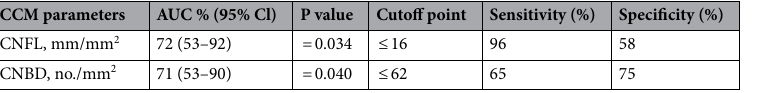
Table 3. Receiver operating characteristic (ROC) curve analysis for the diagnostic accuracy of corneal confocal microscopy for identifying patients with poor compared to moderate-good collaterals.